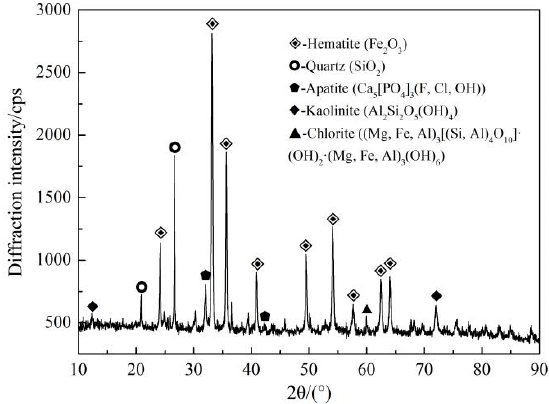
Figure 1. XRD pattern of oolitic iron ore.